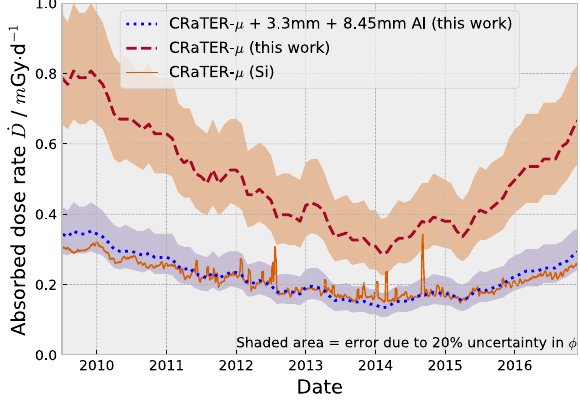
Fig. 8. To compare against CRaTER measurements, which are shown using a orange full line, we used two CRaTER -like phantoms: one without any shielding (red dashed line) and one with shielding corresponding to the actual shielding surrounding the CRaTER microdosimeter (blue dotted line). The agreement between measure- ments and the shielded CRaTER phantom is outstanding, so much that one can even interpret the variations in the measurements to be a consequence of the modelled variations in the GCR fl ux. The time series shown here corresponds to a small portion of the time series shown in Figure